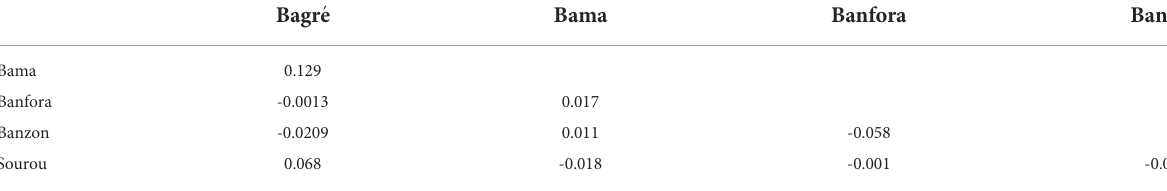
Negative values of F ST are considered as zero values.